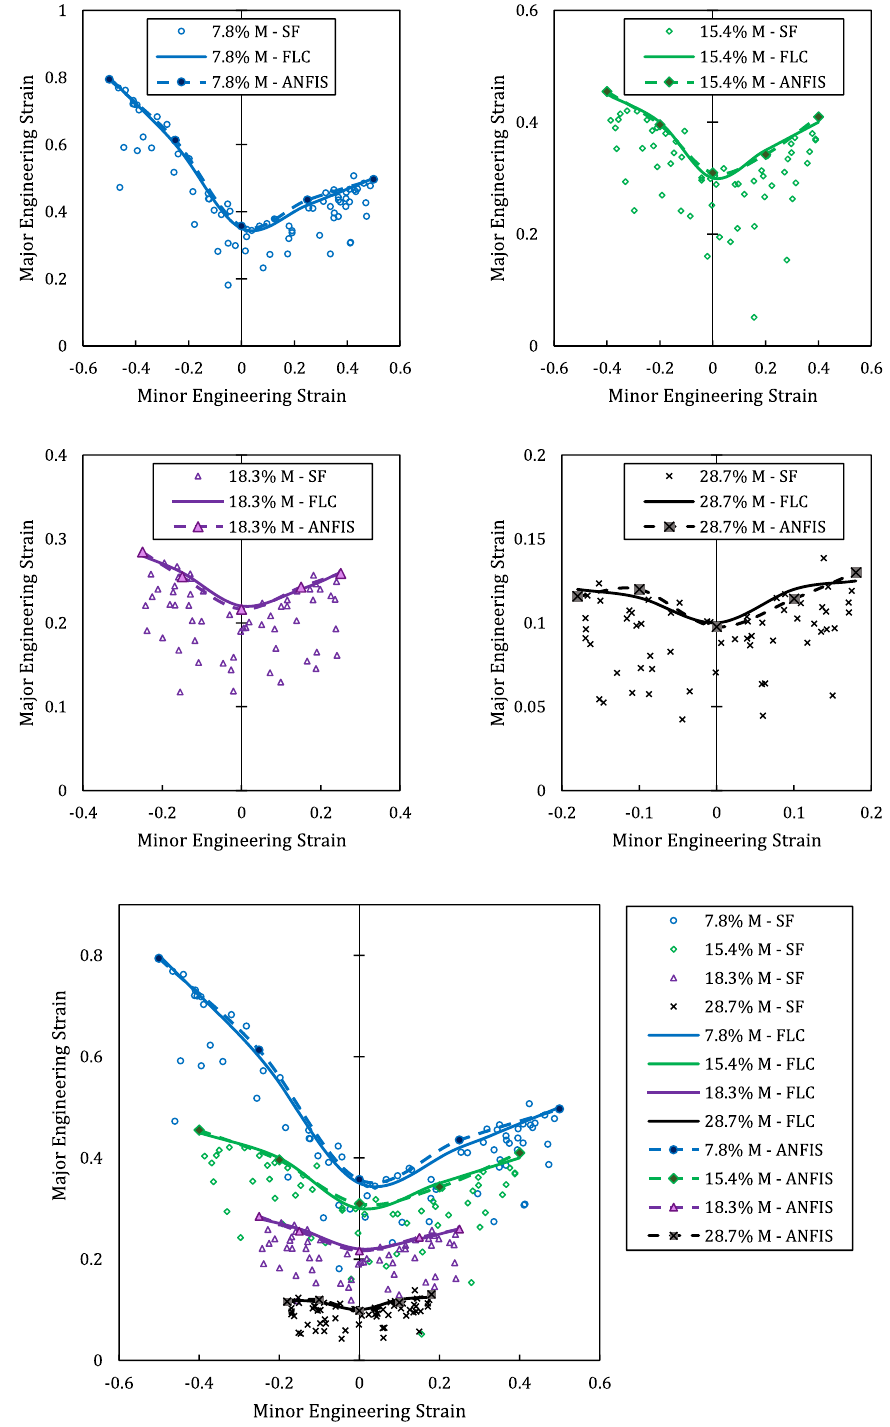
Figure 10. Actual experimental FLCs versus ANFIS-predicted curves for different martensite fraction conditions. These curves are utilized for training